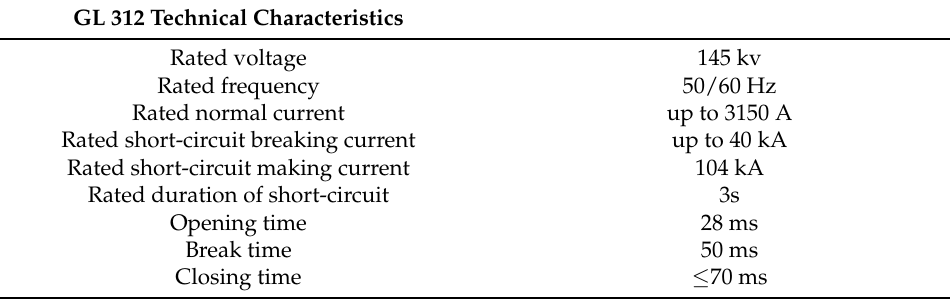
Table 1. Technical Characteristics of the HVCB GL